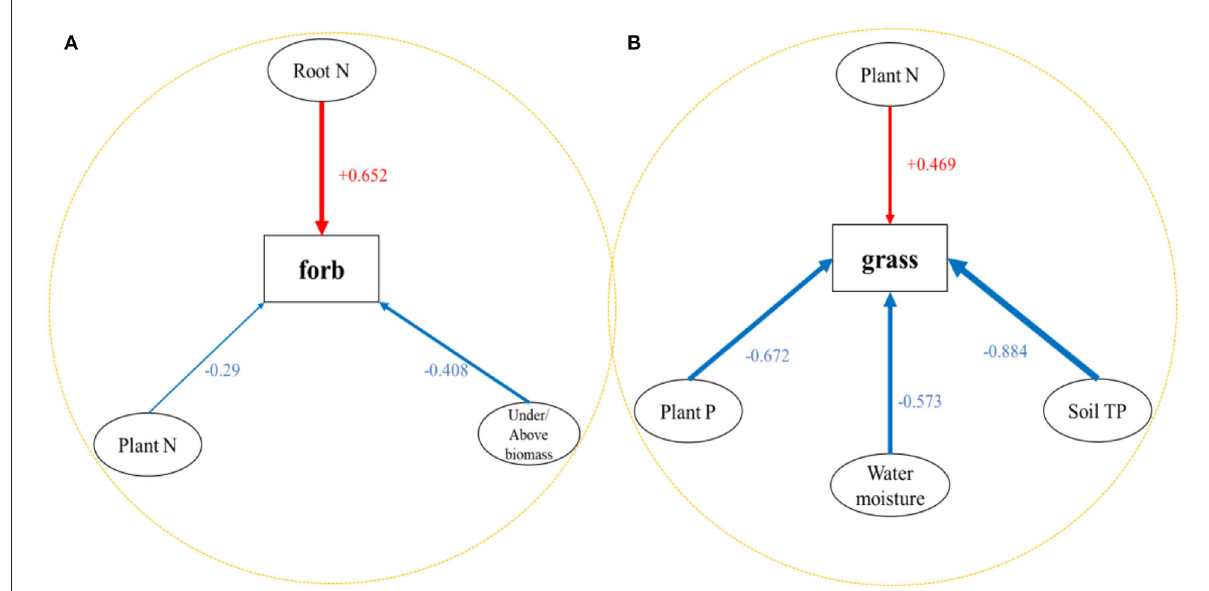
FIGURE5 Schematic diagram of the relationship between (A) forb and (B) grass and different environmental factors. The blue arrow represents the negative effect, and the red arrow represents the positive